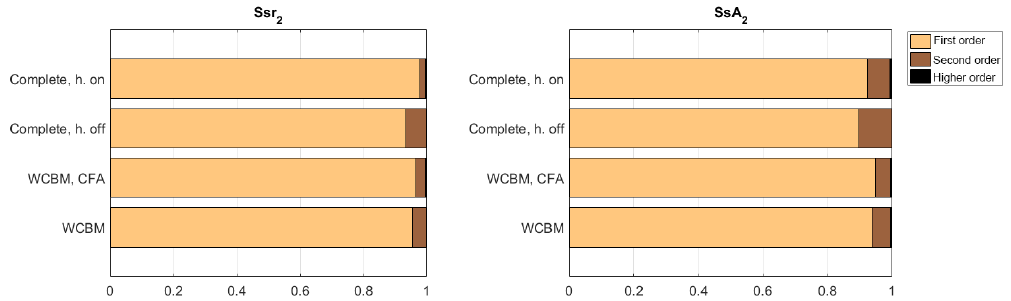
Figure 9. Sensitivity of the stability indices taking into account weave and capsize to first, second, and higher orders of interaction. Models of increasing complexity from bottom to